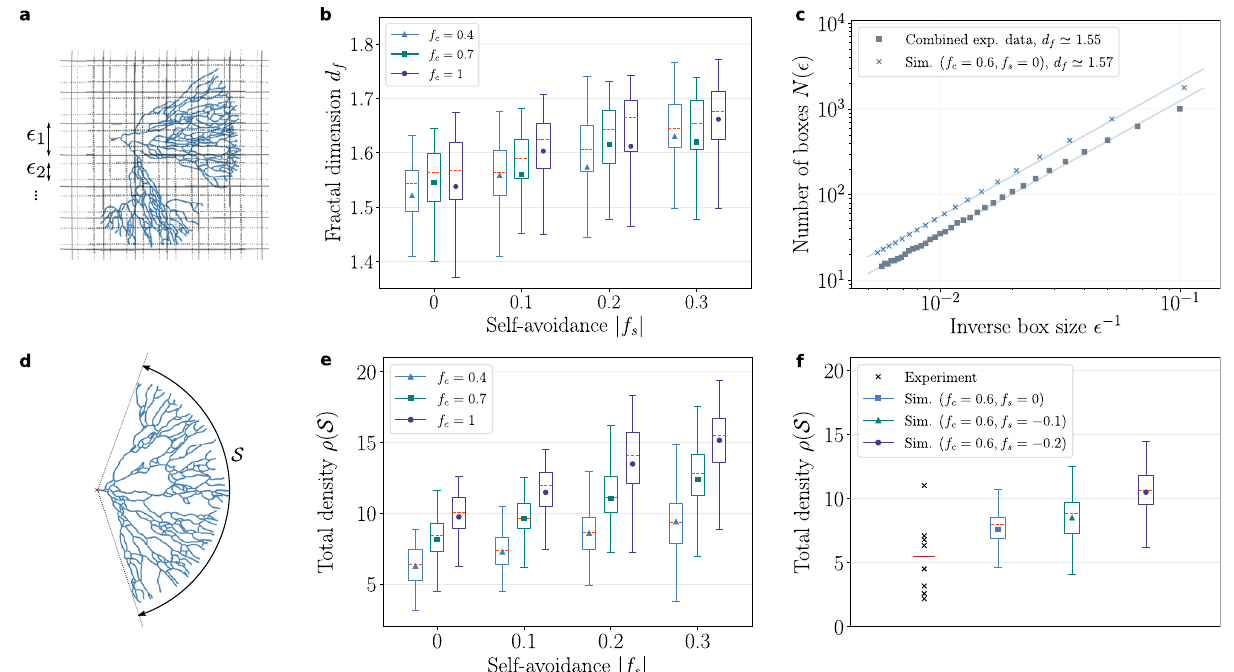
Fig. 5 Effect of self-avoidance and external guidance on branching density and space- fi lling properties. a Fractal dimension of the networks estimated by the box-counting method: Boxes of decreasing sizes ϵ are used to count the total number of boxes that include at least one skeletonized node. b Mean fractal dimensions obtained from the box-counting method increases from 〈 d f 〉 ≃ 1.52 to 〈 d f 〉 ≃ 1.67 with increasing self-avoidance ( f s = 0 to f s = − 0.3), whereas large changes in the external fi eld strength (from f c = 0.4 to f c = 1) have a smaller effect on the mean values. c Combined experimental data from the densest n = 4 networks (circular markers) are consistent with the theoretically predicted power-law: We fi nd a fractal dimension of d f ≃ 1.55, close to the theoretical value d f ≃ 1.57 obtained from the combined data from simulations with f c = 0.6 and f s = 0 (crosses). d Average density ρ ð S Þ of a branched network (ratio of the number of branch segments to the arc length S spanned by the network). e Densities ρ ð S Þ of the simulated networks increase markedly both for increasing external fi eld strength f c and self-repulsion strength ∣ f s ∣ . f Densities ρ ð S Þ obtained from experimental data for n = 8 fi laments (crosses) compared with densities obtained from simulations for f c = 0.6 and f s = 0 (blue box), f s = − 0.1 (green box), and f s = − 0.2 (purple box). Mean density of the experimental data (red horizontal line) is on the lower end of the densities obtained from simulations even for low repulsion, indicating a small value for the parameter f s . For each parameter choice box plots are obtained from n = 100 simulations, with mean and median values denoted respectively by the plot markers and horizontal dashed lines (orange). The boxes are drawn from the fi rst quartile Q 1 to the third quartile Q 3, and whiskers indicate 1.5 interquartile range (IQR ≡ Q 3 − Q 1), i.e., max = Q 3 + 1.5 IQR, min = Q 1 − 1.5